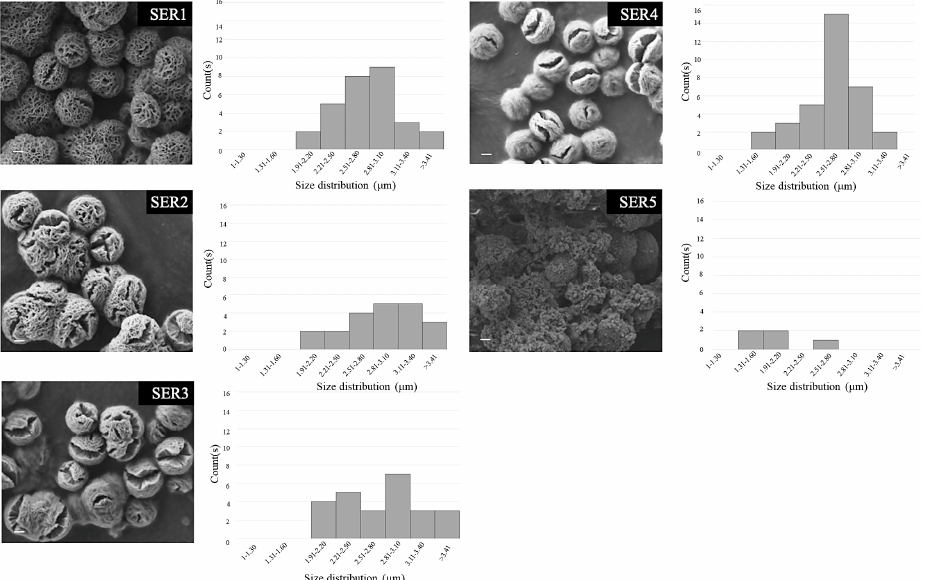
Figure 2. Representative scanning electron microscopy images of Cu-SER MOFs obtained using different silk sericin concentrations (1–5 mg/mL) and their size